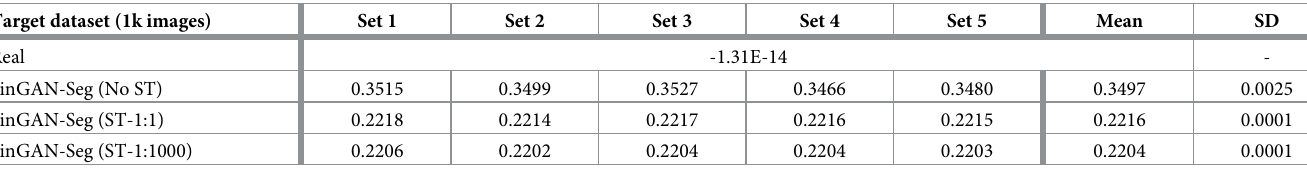
Table 1. SIFID value comparison for real versus fake images generated from the SinGAN-Seg models. Target dataset (1k